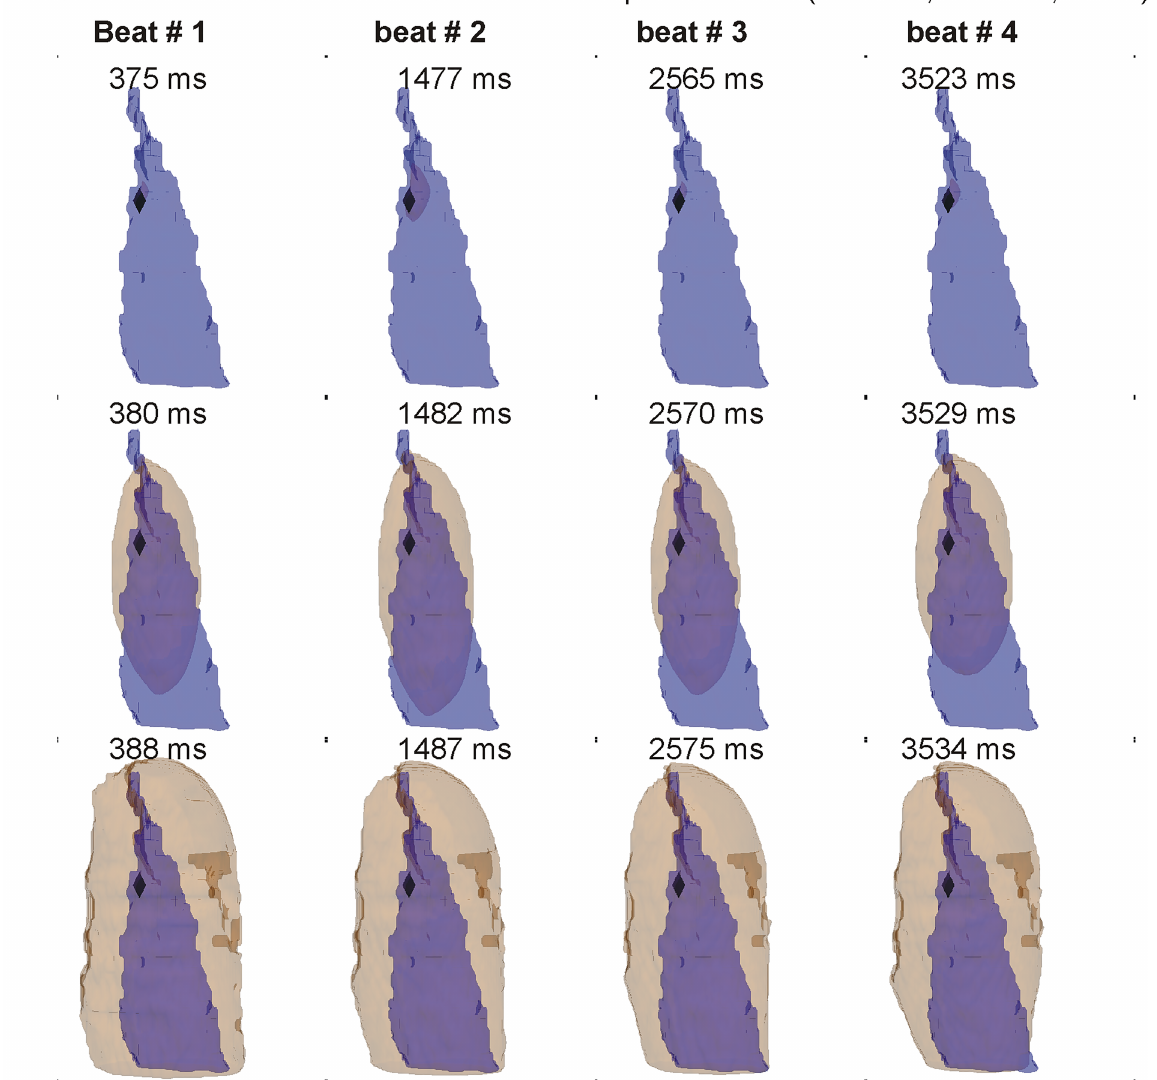
Fig 3. Atrial pacing by the paranodal area. The SAN was replacedby atrial tissue in this simulation. The paranodalarea (blue) with activationwave fronts (beigeiso-surfaces) are shown, but the surrounding atrial tissue is omitted from the panels for clarity. Top row shows epicardialview, whereasbottom row shows endocardial view. The leadingpacemaker site (black star) is within the paranodal area as shownin the snapshots. The period of atrial pacingwas found to be 1564ms.